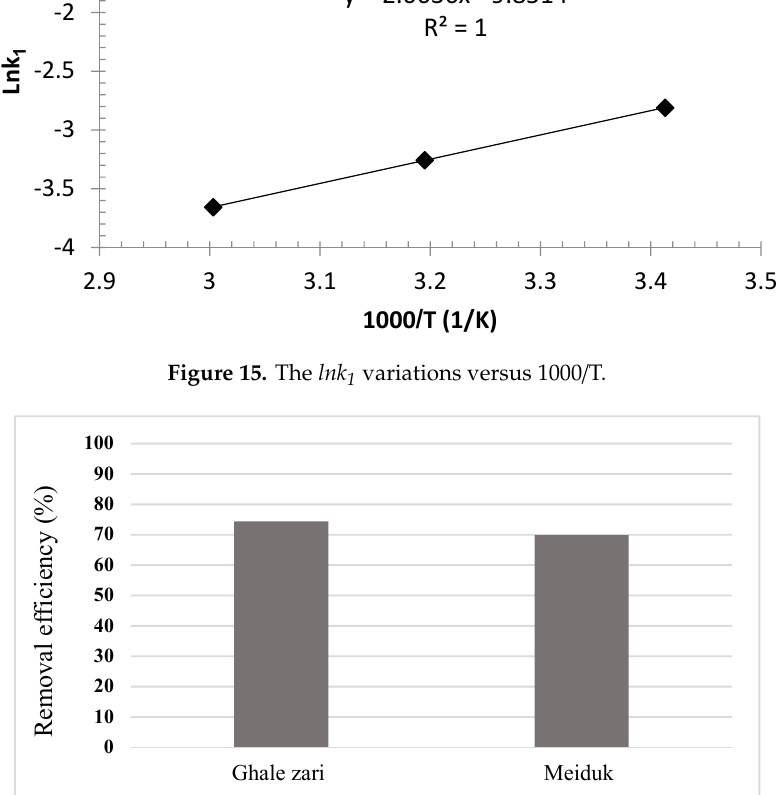
Figure 16. Arsenic removal from industrial mining effluents by synthesized FeNPs.